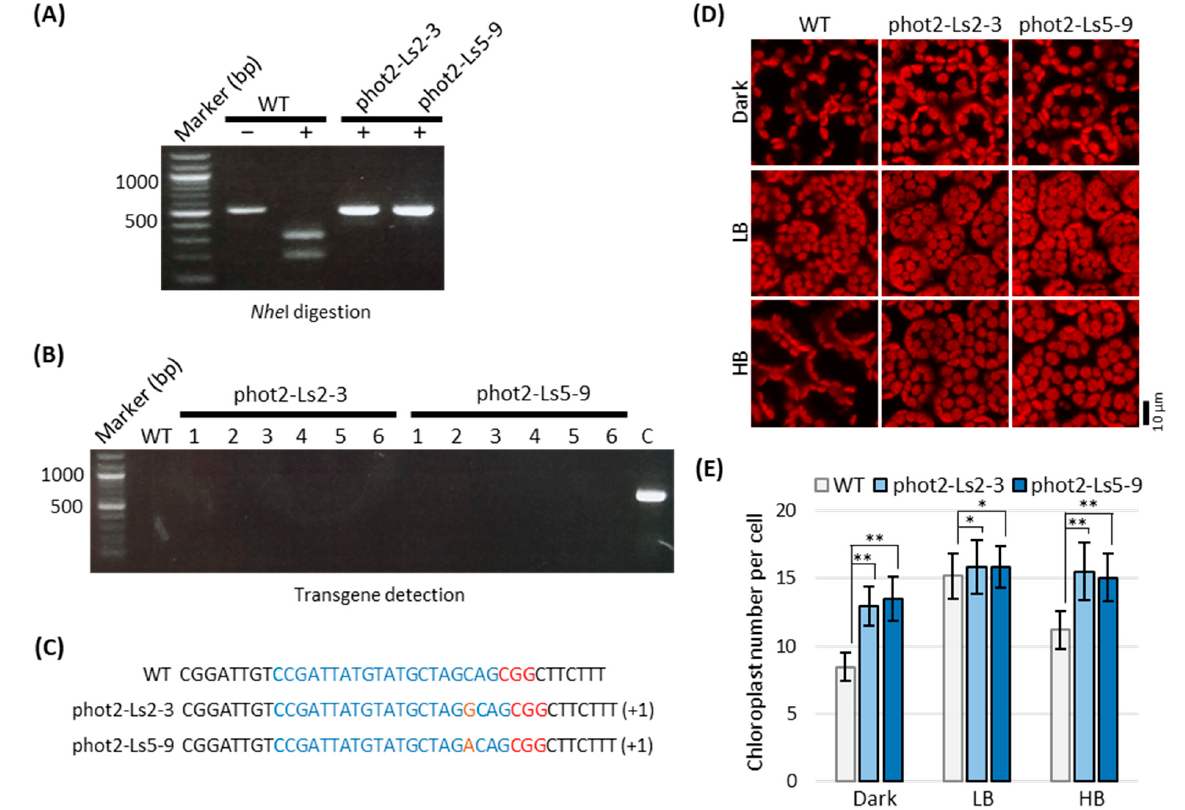
Figure 5. Germline transmission of phot2 mutations in phot2-Ls lines to the R2 generation. ( A ) Detection of phot2 mutations at the sgRNA361 targeting site of the phot2-Ls2-3 and phot2-Ls5-9 lines. Other details are the same as those shown in Figure 3A. Note that the lines are resistant to Nhe I digestion. ( B ) Confirmation of transgene-free in R2 Lsphot2-3 and phot2-Ls5-9 lines. PCR detection was carried out using a Cas9-specific primer set (see Figure 2A). ( C ), PCR control using phot2-Ls2-1 (Figure 4A). ( C ) Sequencing-based detection of phot2 mutations in the R2 phot2-Ls2-3 and phot2-Ls5-9 lines. Other details are the same as those shown in Figure 3B. Note that the genome-edited lines phot2-Ls2-3 and phot2-Ls5-9 are transgene-free and resistant to Nhe I digestion. ( D , E ) Chloroplast movement in the R2 phot2-Ls2-3 and phot2-Ls5-9 lines. Chloroplast positioning ( D ) and chloroplast number per cell ( E ) were investigated in the palisade mesophyll cells of leaves of 4-week-old phot2-Ls2-3 and phot2-Ls5-9 lines under different intensities of blue light. Dark, dark adaptation for 12 h; LB, low-intensity blue light (2 μ mol m − 2 s − 1 ) for 2 h; HB, high-intensity blue light (50 μ mol m − 2 s − 1 ) for 2 h. Note that the phot2-Ls lines are defective in chloroplast avoidance response as well as dark-positioning. Scale bar in D = 10 μ m. Data in E represent the mean ± SE ( n = 15 cells). Asterisks indicate statistical significance detected by Student’s t -test: * p > 0.05, not statistically significant; ** p < 0.0001, statistically significant.